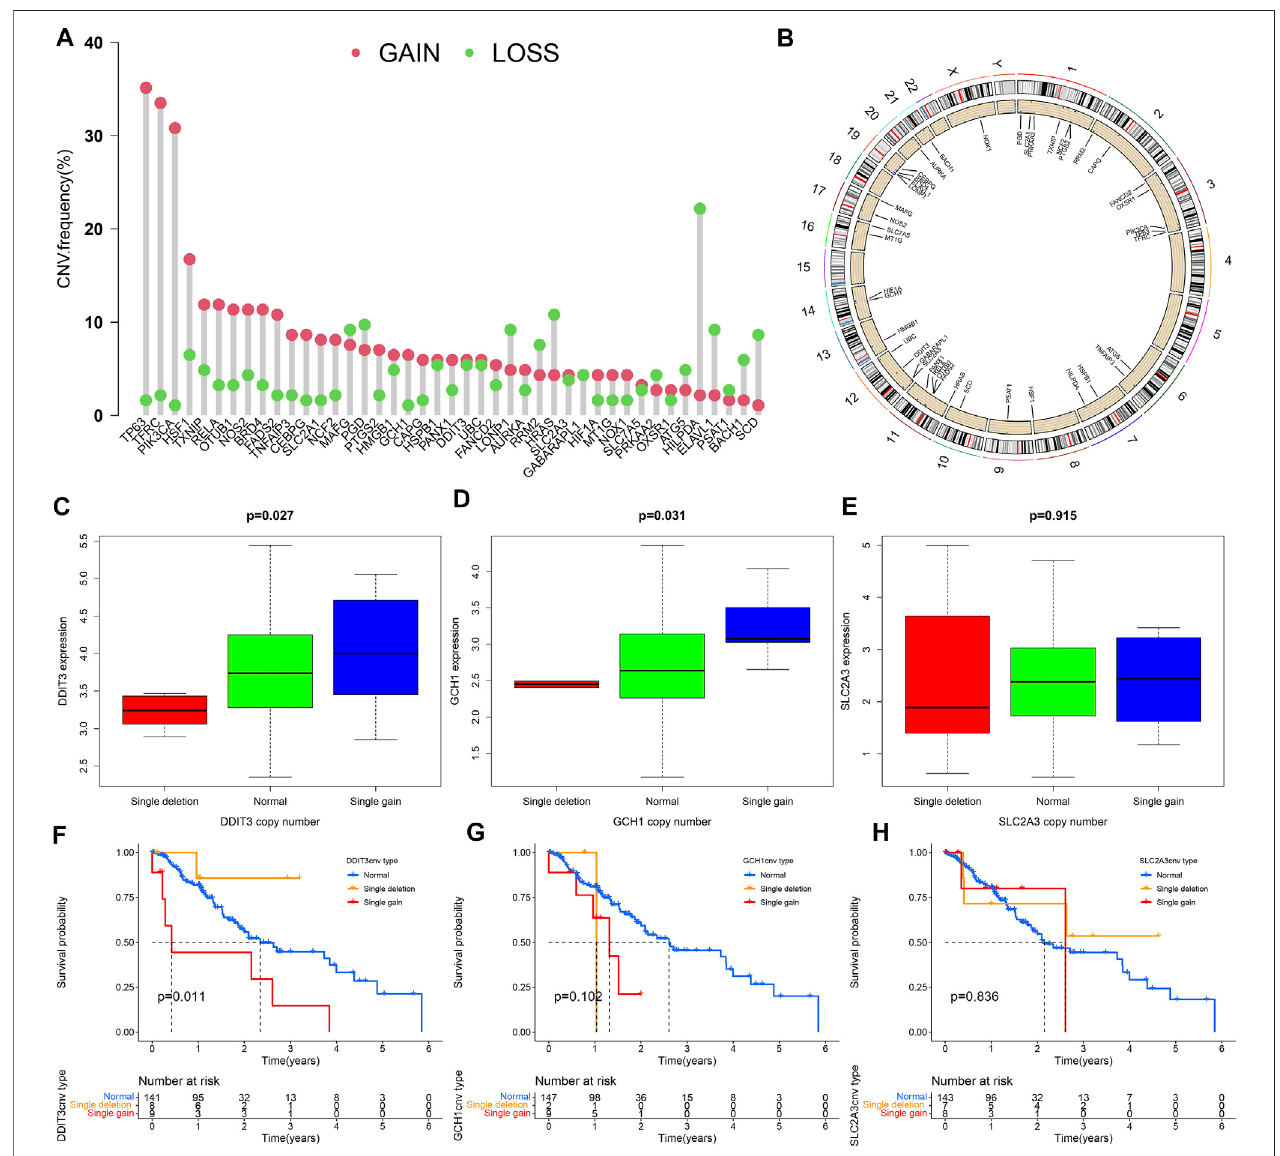
FIGURE 9 | Copy number variation (CNV) analyses. (A) Frequency ofCNV for 43 of the DE-IRFeGs. The green circle refers tocopy number loss and the pink circle refers to copy number gain. (B) Distribution of 43 DE-IRFeG CNVs by position along the human chromosomes. (C – E) Three PR-DE-IRFeGs (DDIT3, GCH1, and SLC2A3) expression levels for normal, single deletion, and single gain copy number groups. (F – H) Survival rates among single deletion, normal, and single gain copy number groups of the three PR-DE-IRFeGs (DDIT3, GCH1, and SLC2A3),